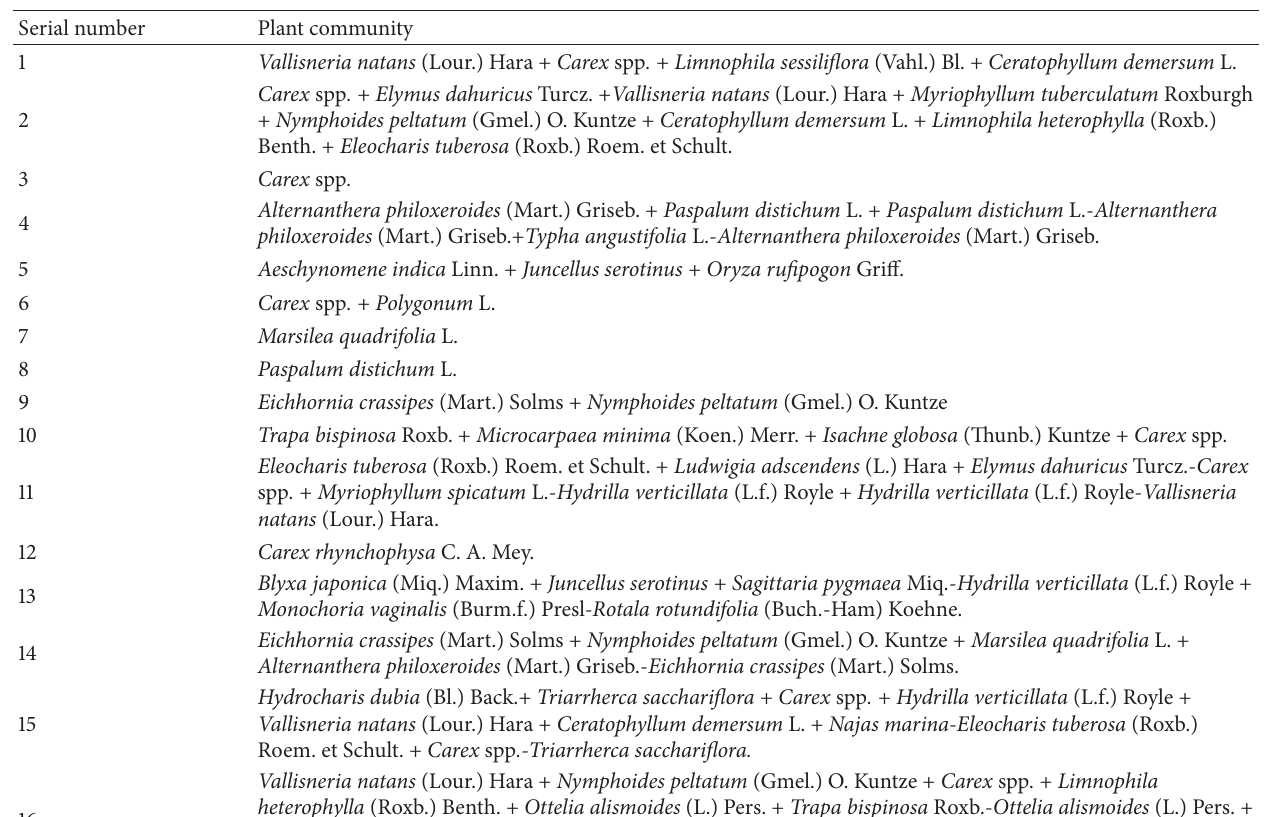
Table 2: The aquatic plant’s association types in the Poyang